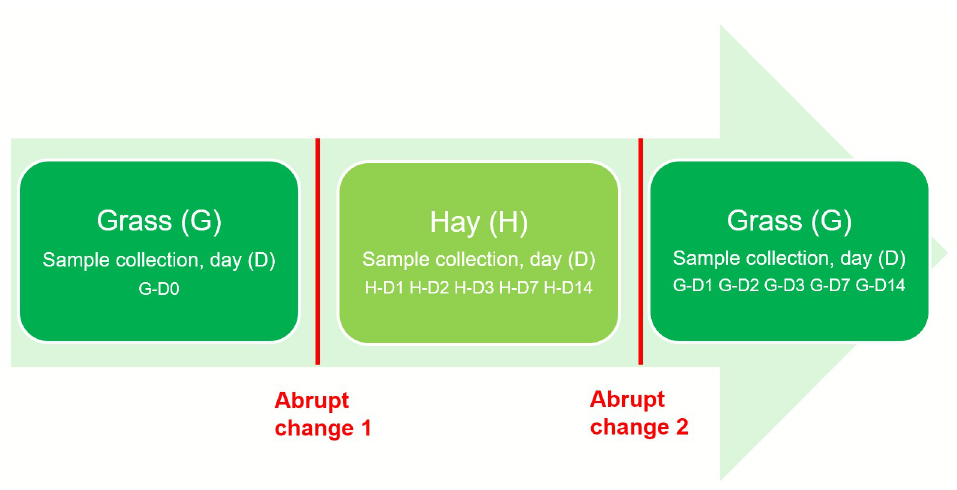
Fig 1. Experimental design employed to study the effect of abrupt dietary changes on the faecal microbiota of ponies (n = 6).